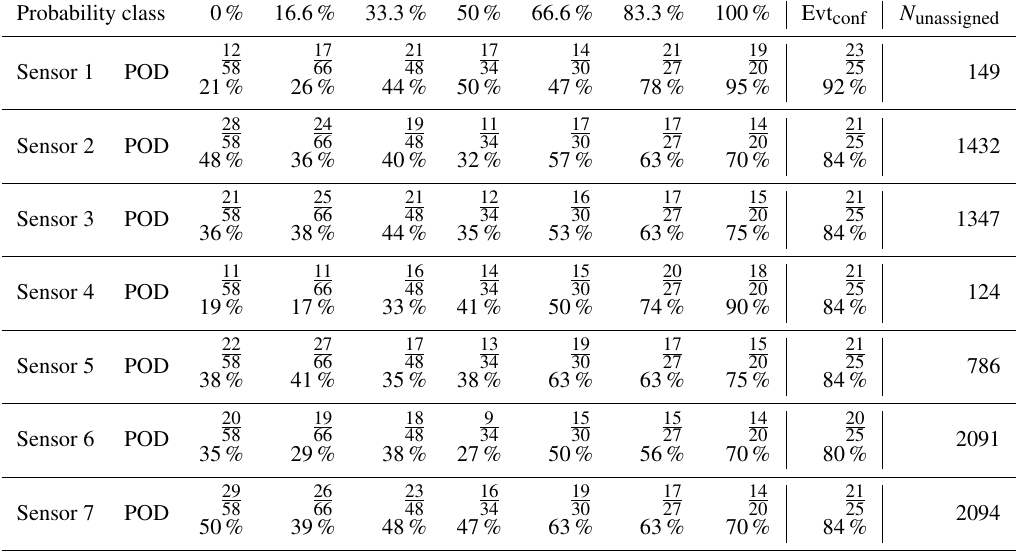
Table 2. Number of detections ( N hit ) and probability of detection (POD) for each sensor and each probability class as well as the POD for confirmed events Evt conf and number of events that were not in the reference data set ( N unassigned ).